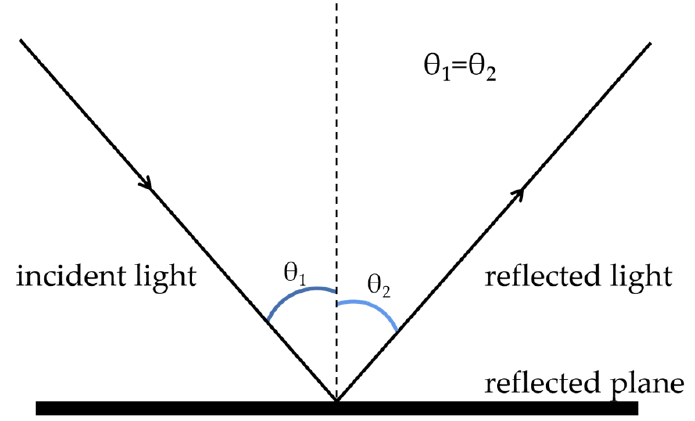
Figure 11. Reflectance law. For a reflective pointer meter, after its image perspective transformation, the improved k-means algorithm will be used to detect its reflective areas. Then, the specific position information of the reflective areas on the pointer meter can be obtained to determine the motion direction and distance for the robot’s